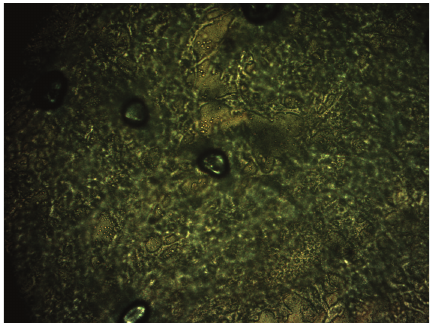
Figure11:POMmicrographofPLA/PBAT(30/70)inthequenching